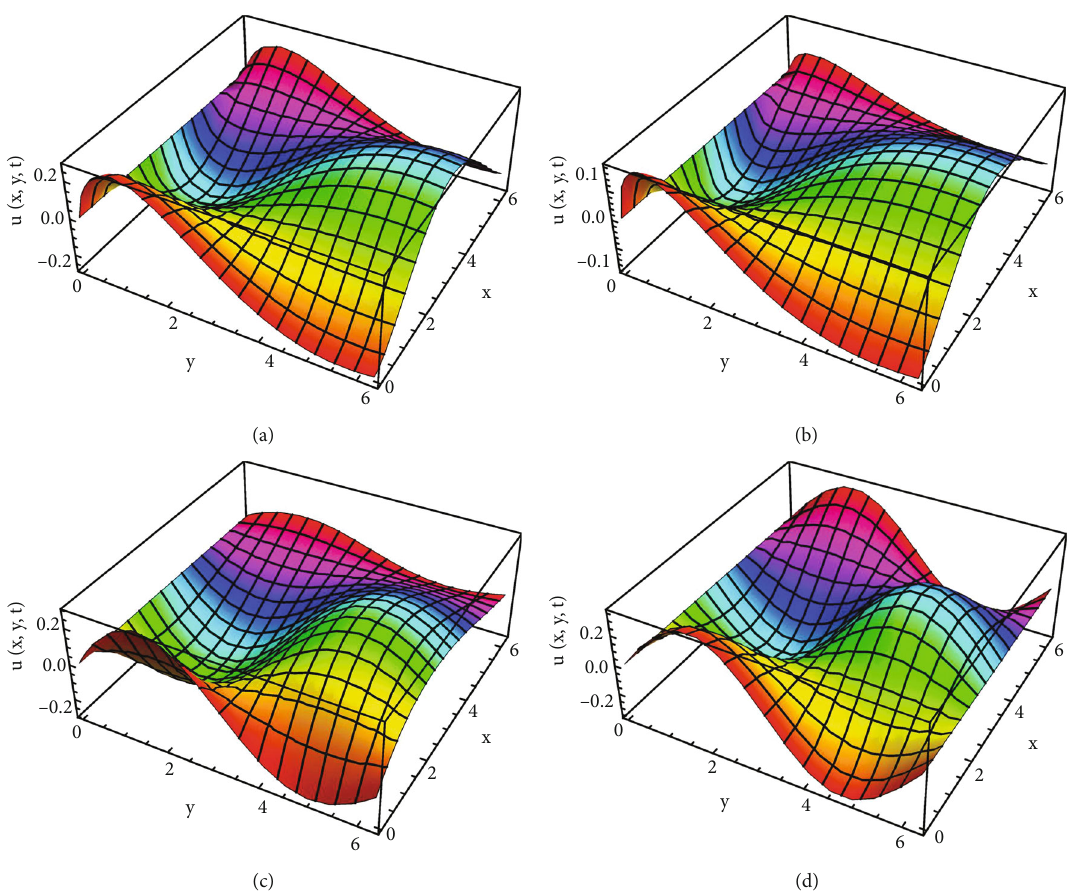
Figure 2: 3D solution plots of Example 1 at (a) α = 0 : 4, β = 0 : 5, γ = 0 : 7, t = 0 : 2 , (b) α = 0 : 5, β = 0 : 6, γ = 0 : 8, t = 0 : 4, (c) α = 0 : 7, β = 0 : 9, γ = 0 : 5, t = 0 : 8, and (d) α = 1, β = 1, γ = 0 : 9, t = 1